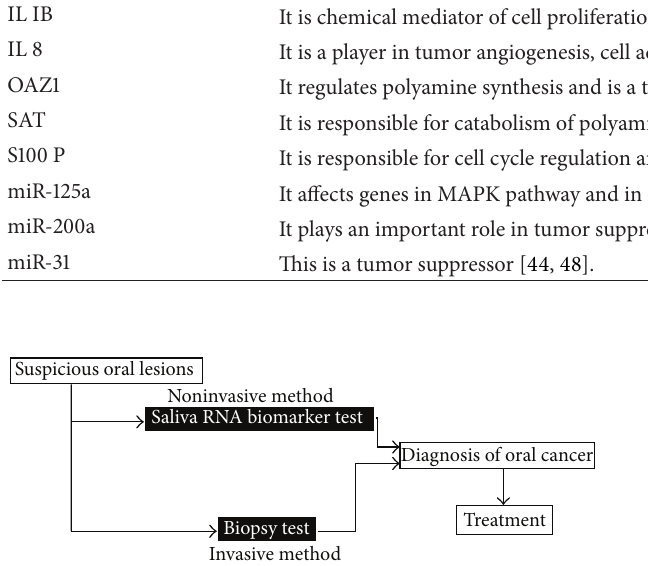
Figure 1: Invasive method versus noninvasive method for diagnos- ing oral